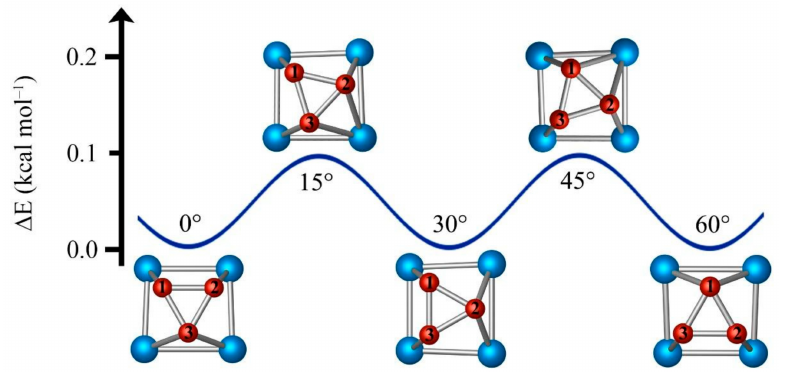
Figure 3. Structural evolution of three-dimensional molecular Reuleaux triangle B 3 Al 4+ during the dynamic